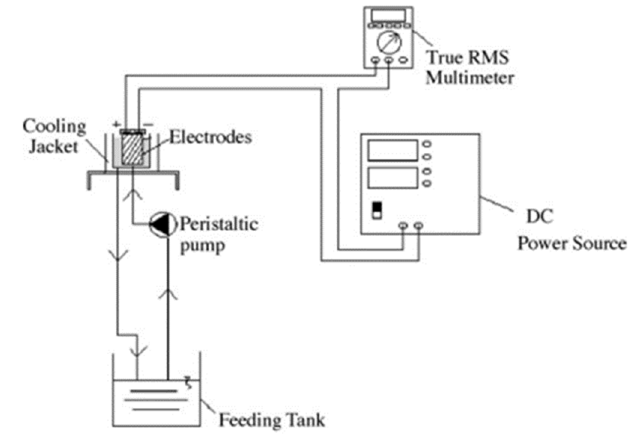
Figure 4. The electrochemical process used for the treatment of OMW. Reprinted with permission from Reference [60]. Copyright 2008. Elsevier.